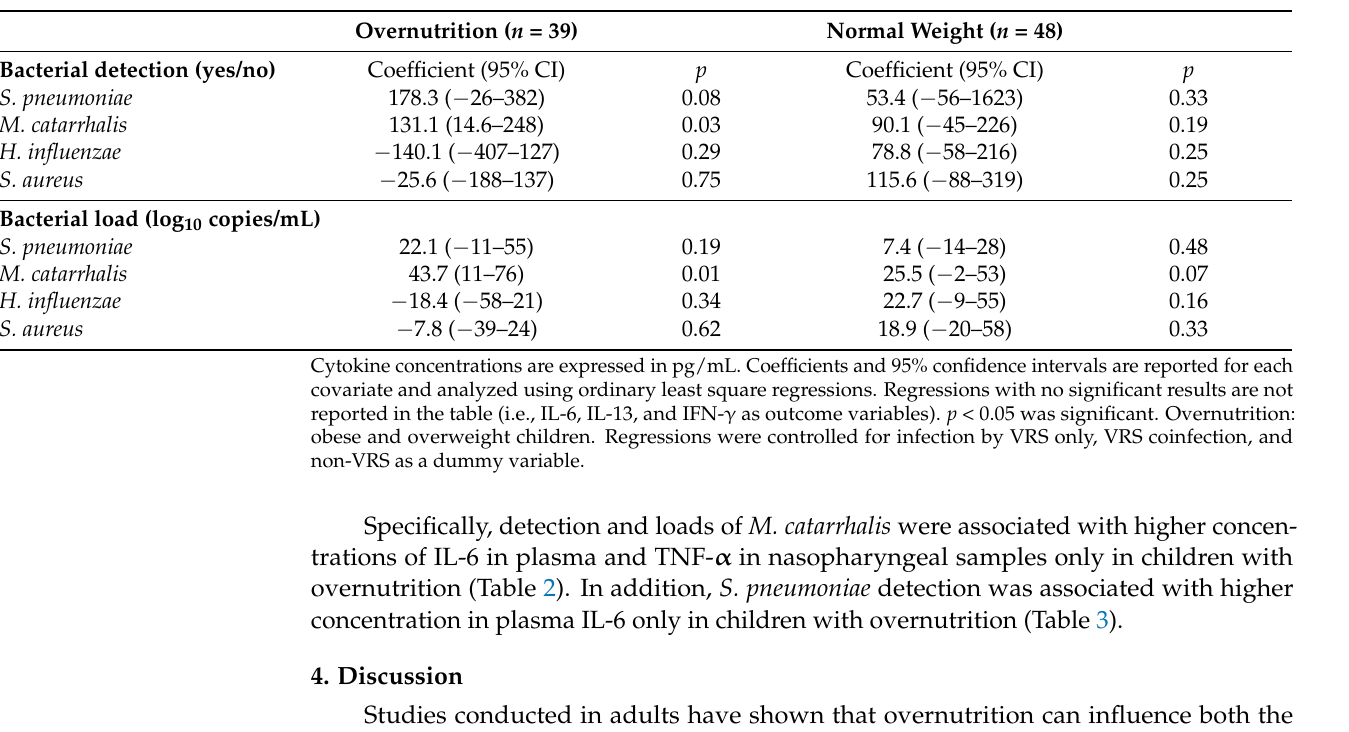
Table 3. Relationship between Nasopharyngeal Bacterial Detection and Bacterial Loads with Mucosal TNF- α According to Nutritional